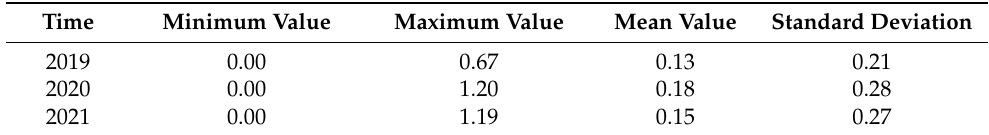
Table 11. The descriptive statistical results of system